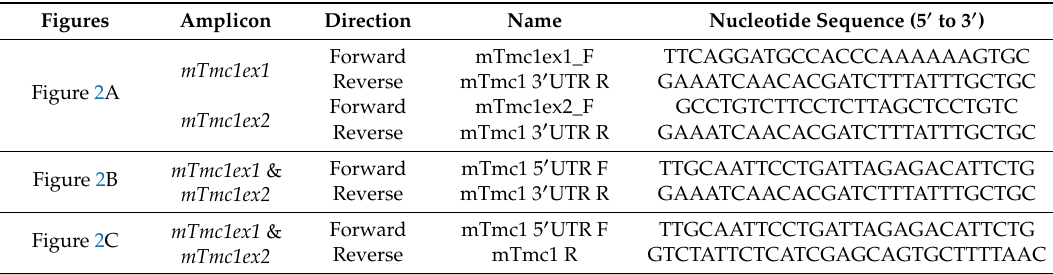
Table 1. Sequences of the primers